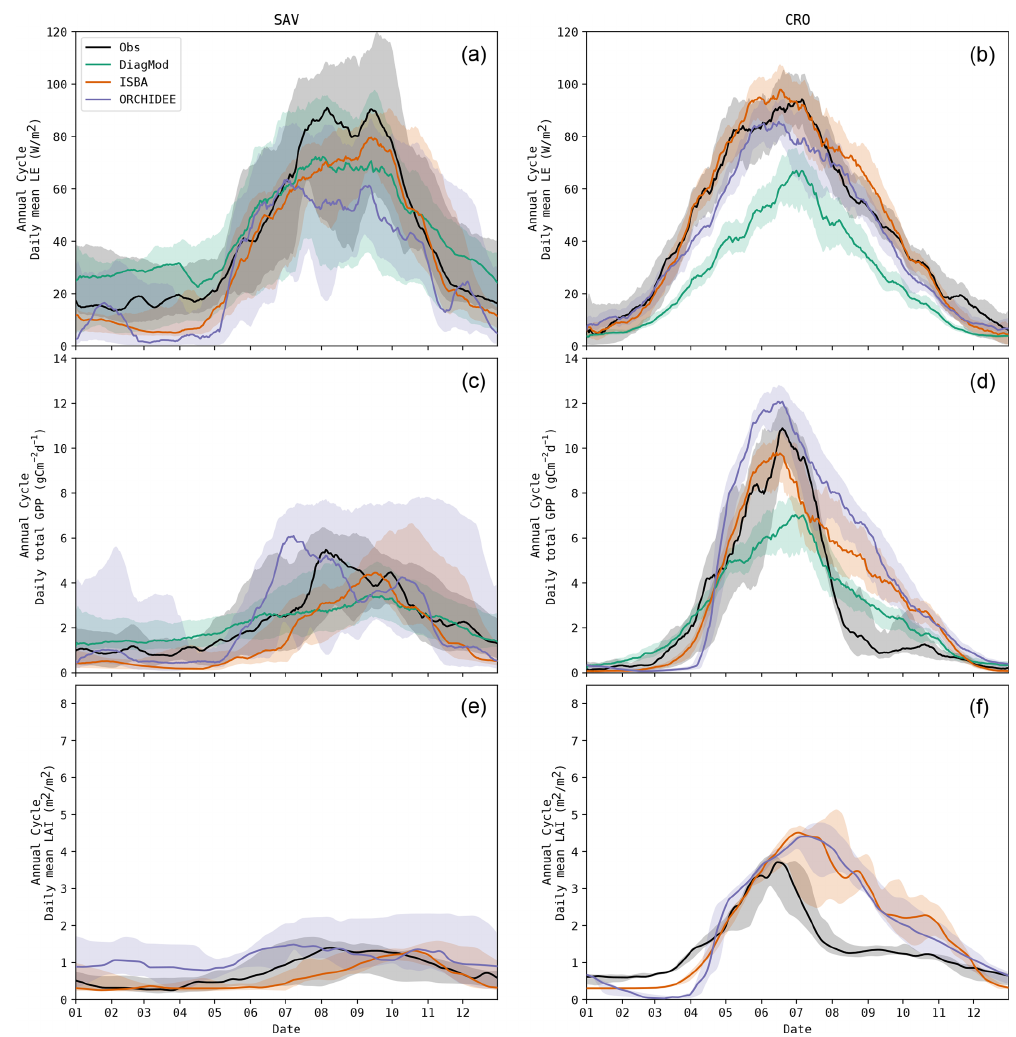
Figure 7. Mean annual cycle for LE , GPP and LAI at all savanna (a, c, e) and crop (b, d, f) sites, observed and simulated.